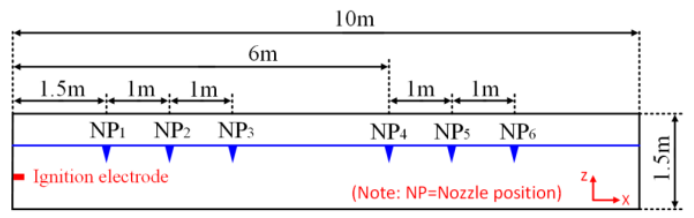
Figure 5. Water mist nozzle layout in experimental studies [48].